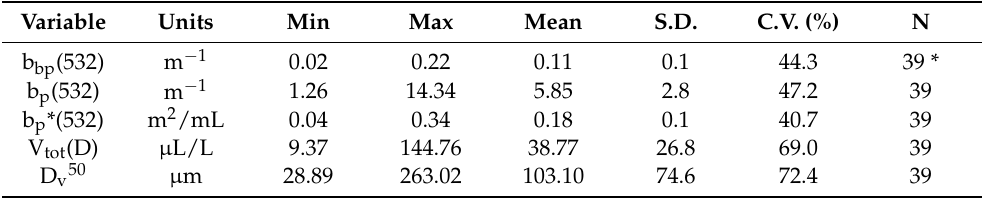
Table 2. Descriptive statistics for particulate backscattering b bp ( λ ), scattering b p ( λ ),